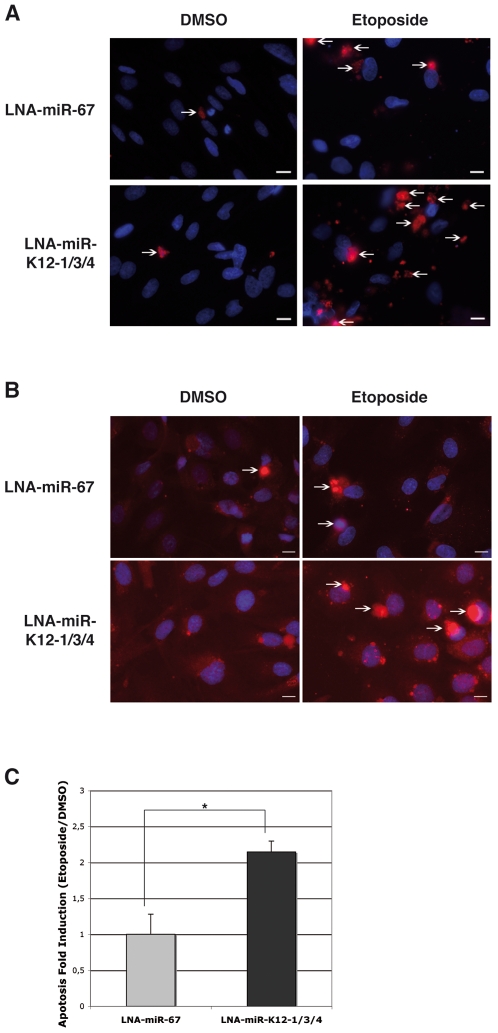
KSHV miRNAs inhibit apoptosis in KSHV-infected endothelial cells.
A. Microscopic analysis following DAPI (blue) and cleaved Casp3 (red) staining of K-iLEC cells treated with DMSO or etoposide, and after KSHV miRNA inhibition by tiny LNA (LNA-miR-K12-1/3/4) or the control (LNA-miR-67). Arrows indicate cells that were counted as cleaved Casp3 positive. Bar size is 10 µM. B. Microscopic analysis following DAPI (blue) and TUNEL (red) staining of K-iLEC cells treated with DMSO or etoposide, and after KSHV miRNA inhibition by tiny LNA (LNA-miR-K12-1/3/4) or the control (LNA-miR-67). Arrows indicate cells that were counted as TUNEL positive. Bar size is 10 µM. C. Mean apoptosis fold induction measured from three independent TUNEL experiments; a significant difference of apoptosis induction (p = 0.0056) is observed between the LNA-miR-67 and the LNA-miR-K12-1/3/4 treatment.